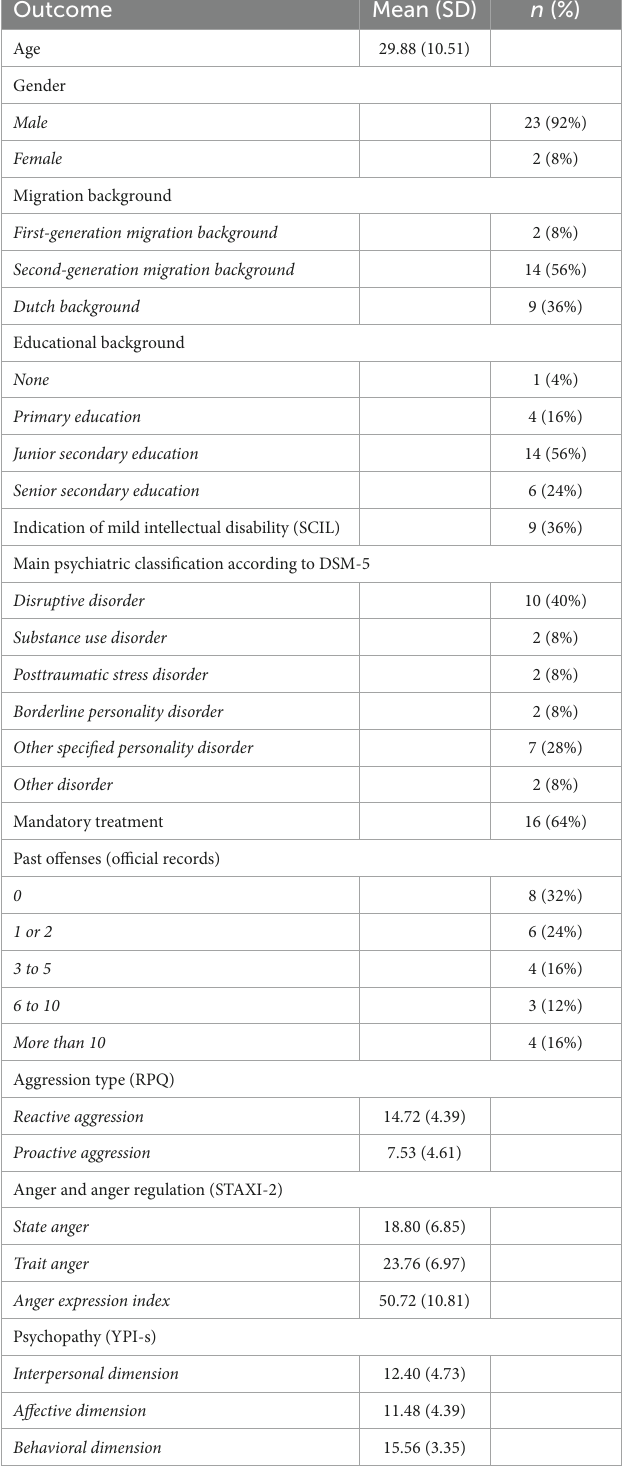
TABLE 2 Demographic characteristics ( N =